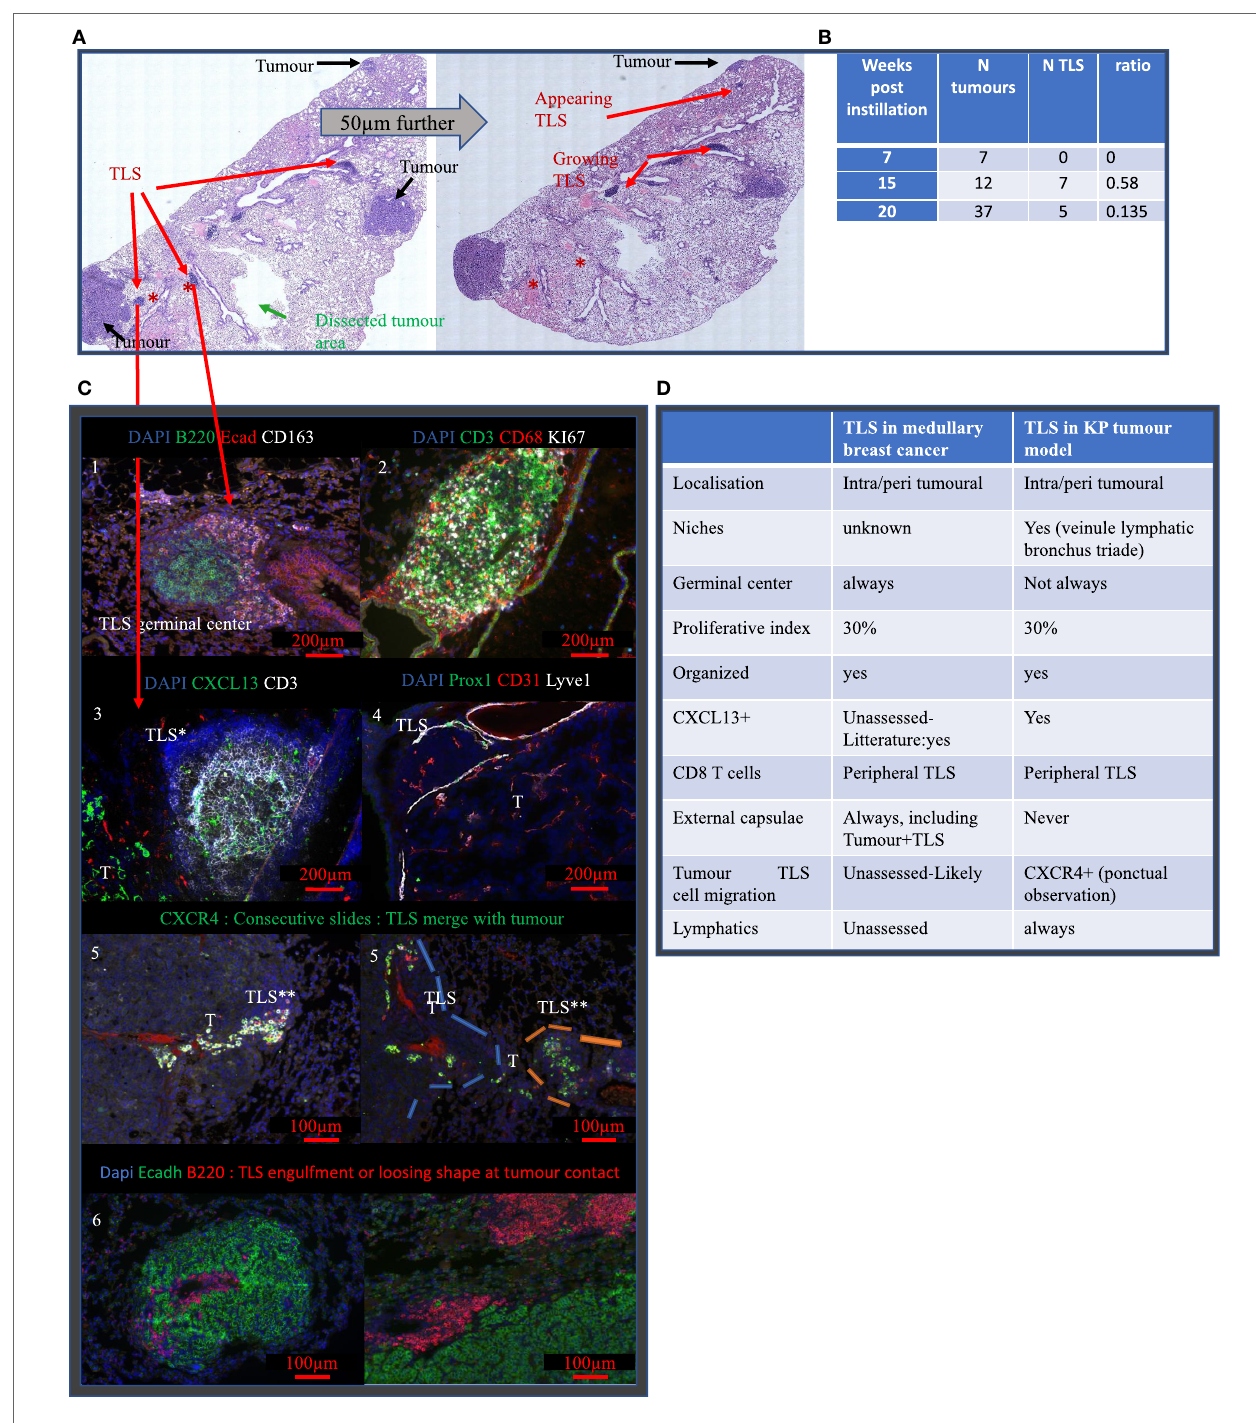
FigUre 2 | Tertiary lymphoid structures (TLS) appear after tumor onset are maintained during disease progression and share common features with TLS in MBC. (a) Full KP lung section H&E stained. TLS are shown by red arrows, they are located around bronchus. Analysis on serial sections is required for proper TLS detection that can be present in one section and absent in 50 µm further. Green arrow showed the area of macro-dissected tumor used for flow cytometry. (B) KP lungs were sampled at 7, (timing of tumor occurrence), 15, and 20 weeks (final stage) post-cre installation. Tumor and TLS quantification were performed based on H&E staining similar to (a) . TLS appeared after tumors’ onset. (c) Representative images are shown and illustrate common properties of TLS from KP and MBC such as the presence of germinal center and organizational features (1), 30% of proliferation (2). Additional stainings were performed. They show expression of CXCL13 chemokine (3), down left corner positive signal comes from the tumor (T), presence of Prox1 + Lyve1 + CD31 + lymphatic vessels (4). Picture 5 shows presence of aligned CXCR4 + cells in between TLS and tumor T. Picture 6 shows TLS engulfed by the tumor. Common features of KP versus MBC TLS are summarized in table (D)